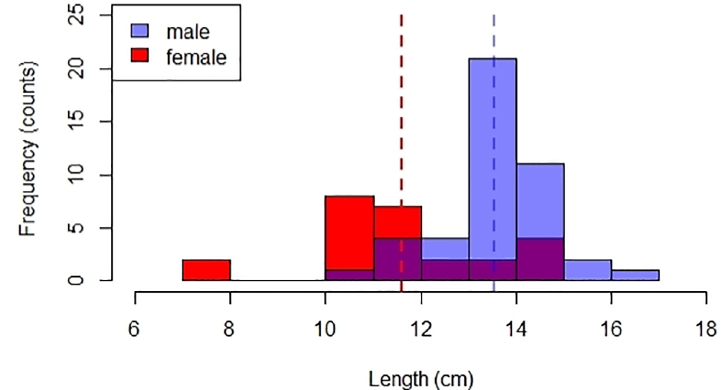
Figure 5. Total length (TL) distribution of male (n=44) and female (n=25) payangka ( Giuris laglaizei ) from Bolano Sau Lake. Dotted lines indicate mean TL for male (blue) and female (red)